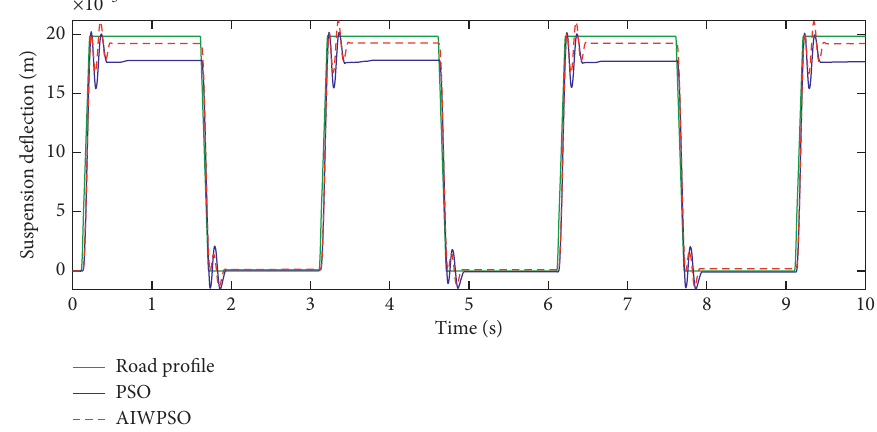
Figure 16: Suspension deflection for a trapezoidal